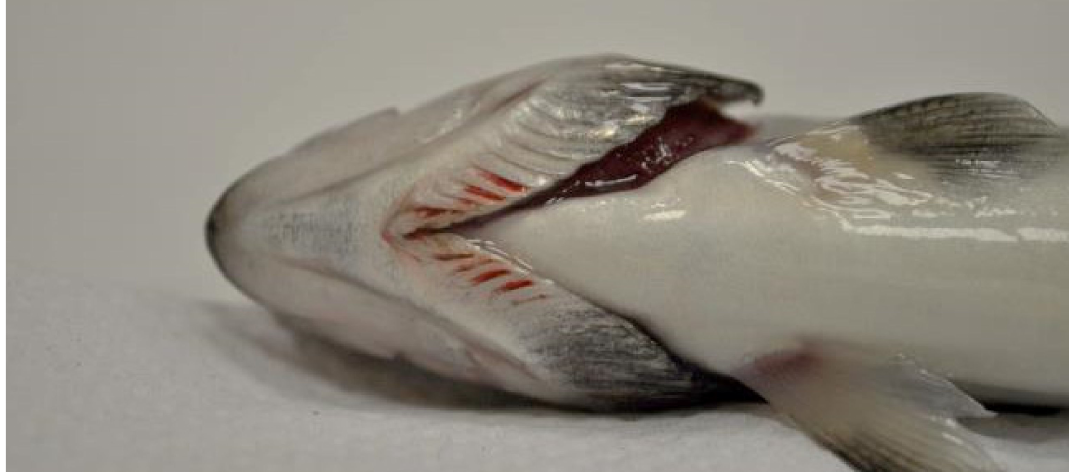
Figure 2. Petechiae visible in the pharyngeal operculum region in the course of